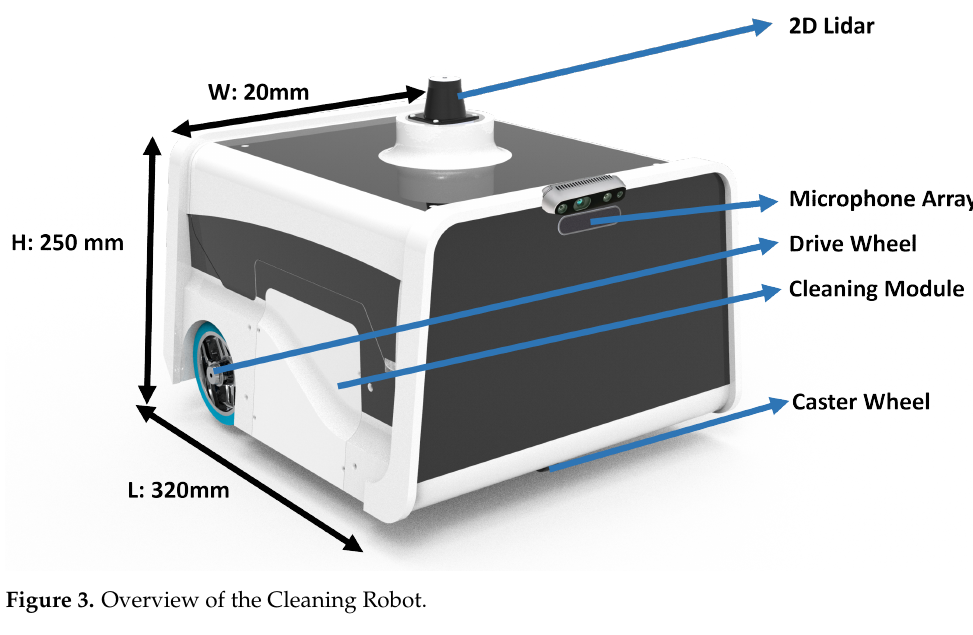
Figure 3. Overview of the Cleaning Robot.